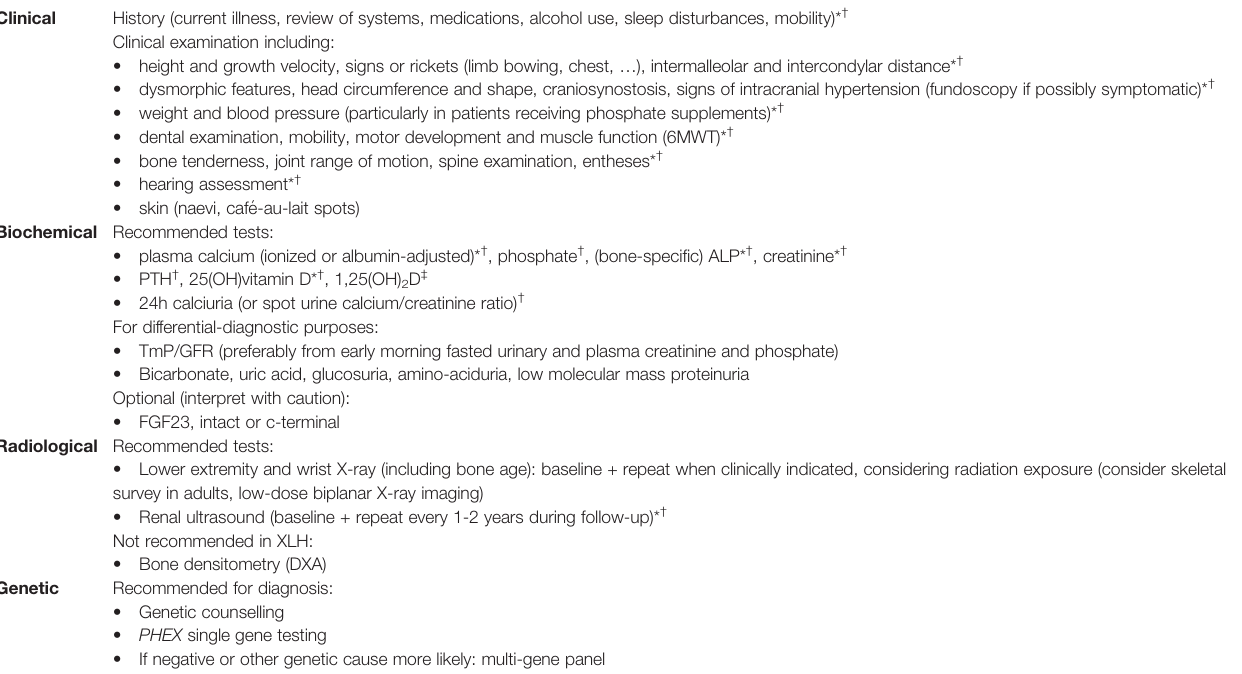
TABLE 2 | Recommended diagnostic and monitoring tests for XLH in Belgium.